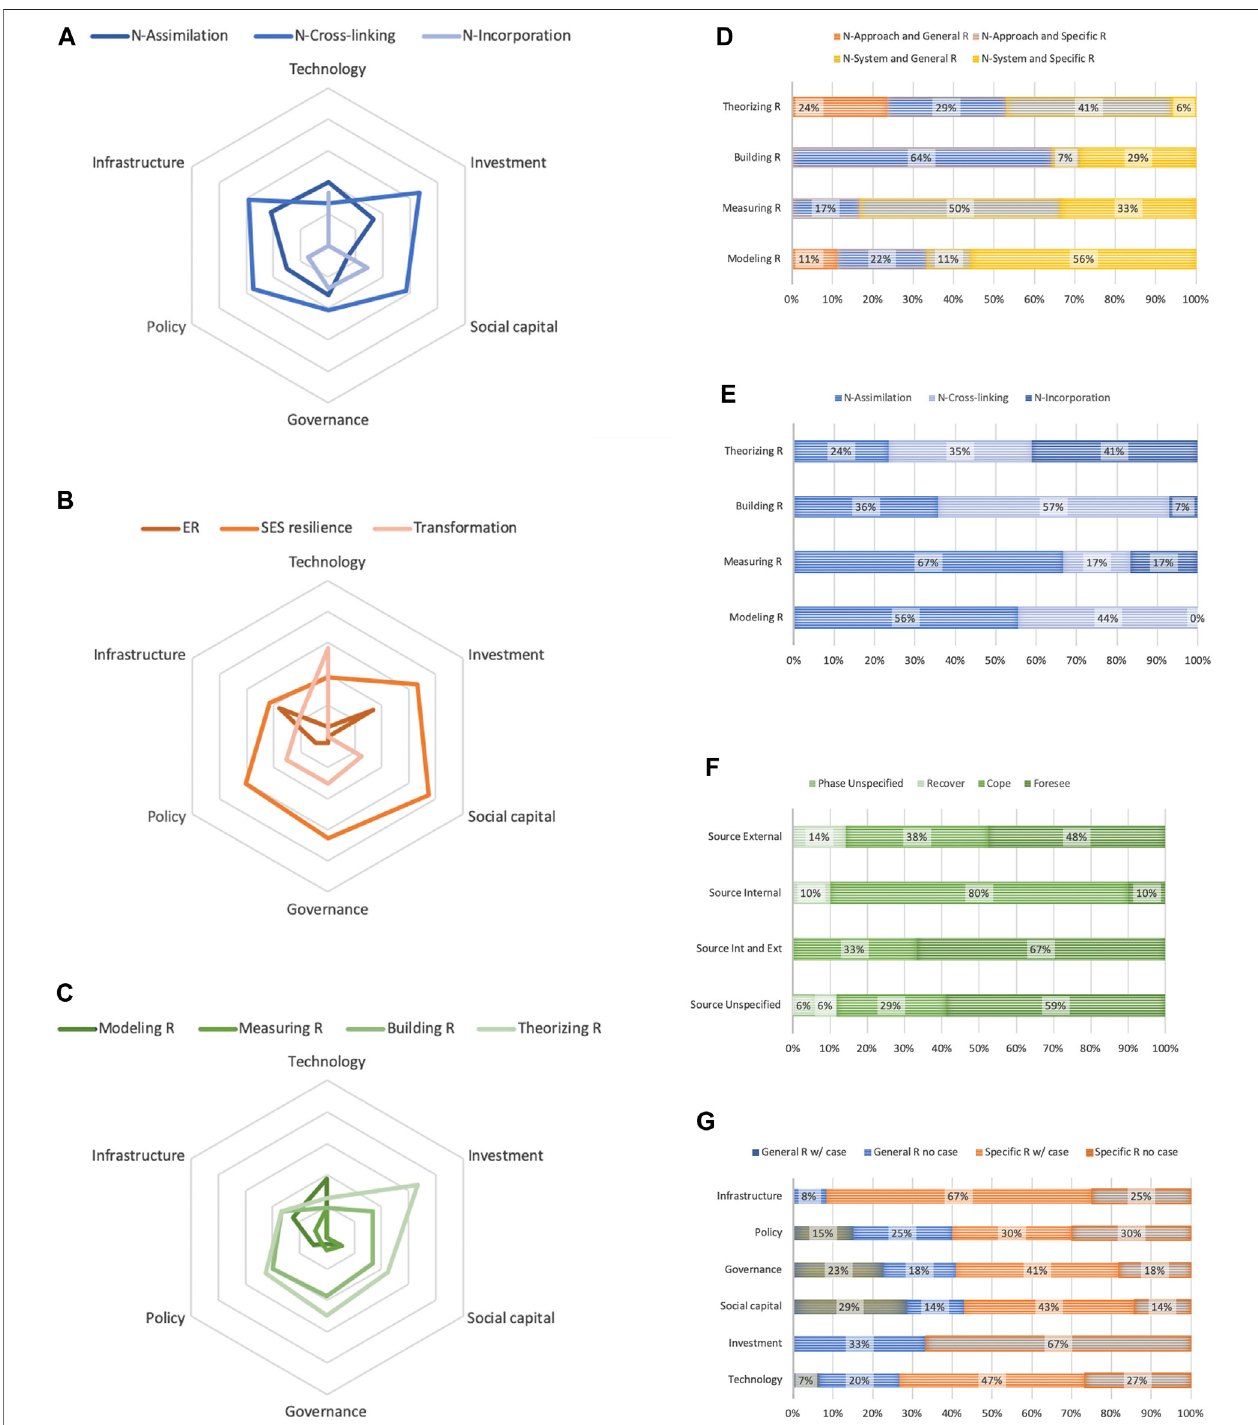
FIGURE 3 | Cross-section of the research landscape across multiple nexus and resilience characteristics. Abbreviations: engineering resilience (ER), nexus (N), resilience (R), social-ecological systems (SES).